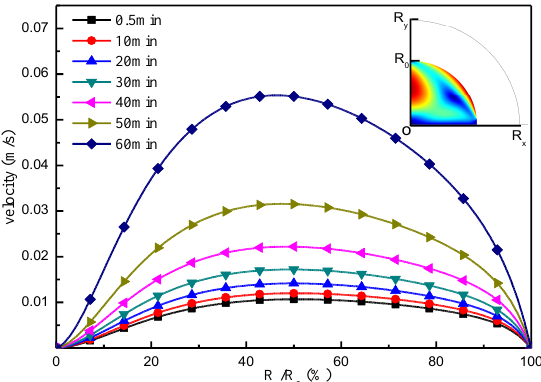
Figure 7. Flow velocity distribution on the droplet centerline.